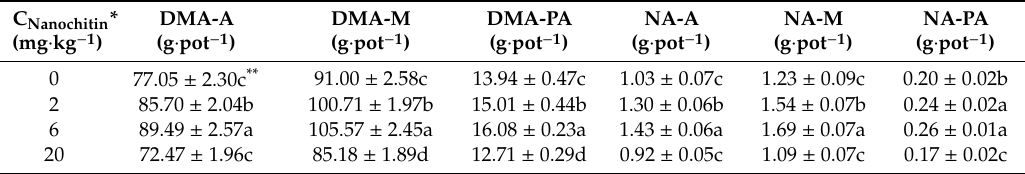
Table 2. Enhancements in dry matter and N accumulation in pre- and post-anthesis of